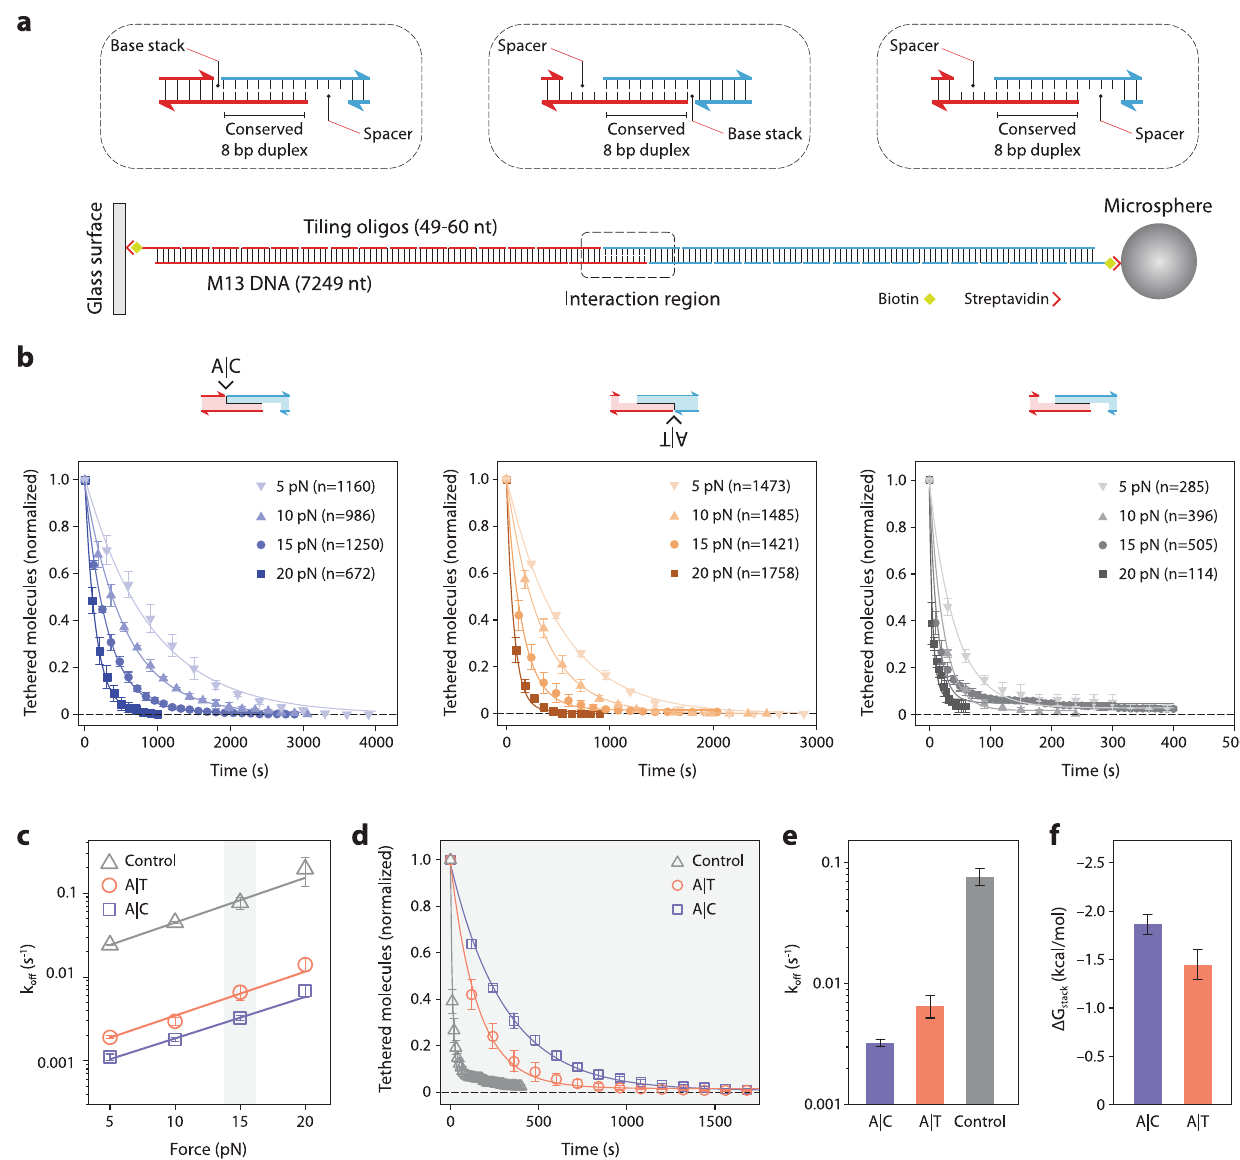
Fig. 3 | Experimental measurement of single base stacking energies. a A weak central 8bp duplex is designed to be fl anked by a terminal base stack or no base stacks. The central interaction is formed between two DNA handles attached to a glass slide and a microsphere through biotin-streptavidin interaction. b Raw data and single-exponential fi ts obtained for the A|C, A|T and control constructs at forces from 5 to 20 pN. c Force-dependent off-rates fi t with the Bell-Evans model (solid lines) to determine thermal off-rate. Force scales determined as 8.8±0.7 pN (A|C), 8.3±1.0 (A|T), and 8.1±0.2 (control), corresponding to transition state